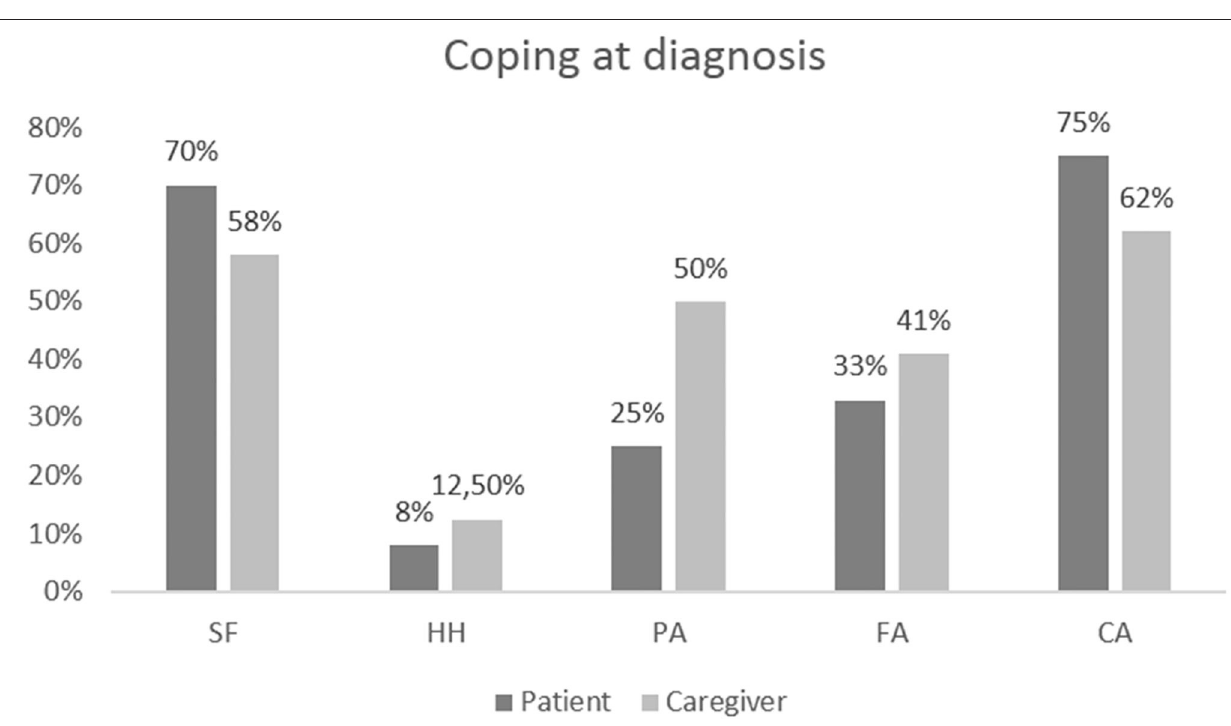
Frontiers in Neurology |